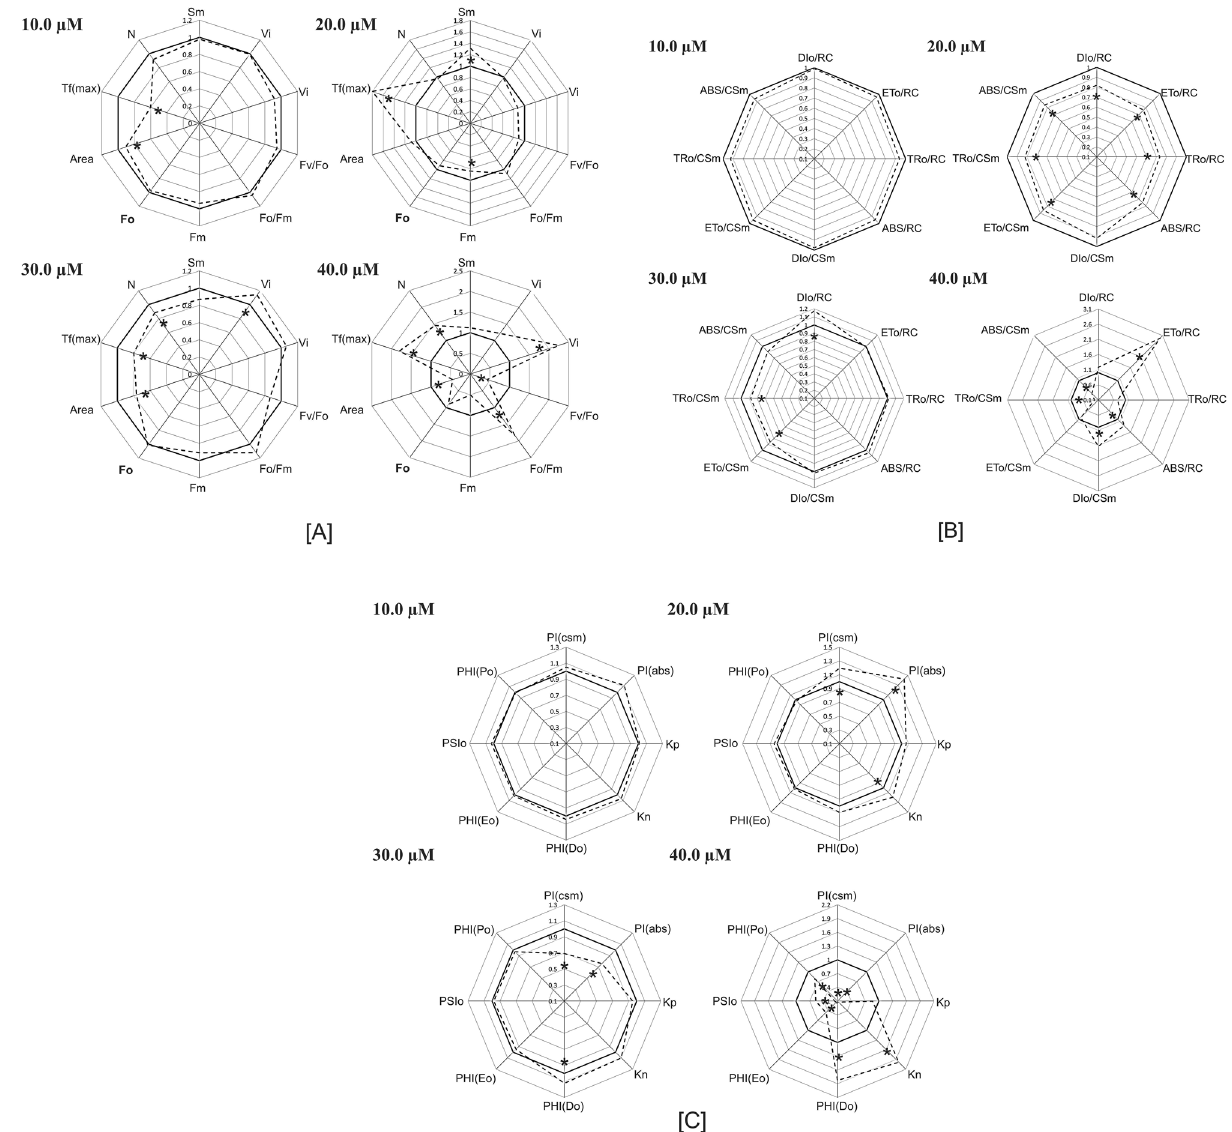
Figure 2. Radar plots ( A–C ) showing various technical fluorescence parameters. Each line represents the average of 6 measurements per treatment. Asterisk denote the significance at p ≤ 0.05